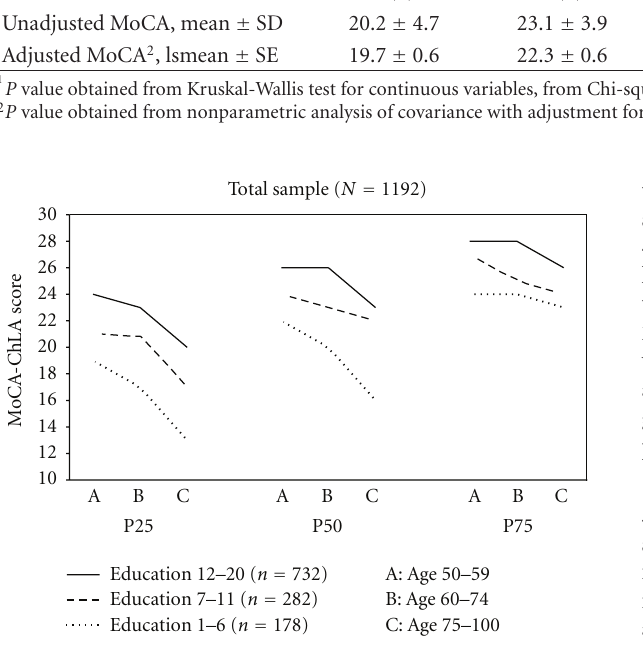
Figure 3: The 25th, 50th, and the 75th percentile of MoCA-ChLA score by age and education